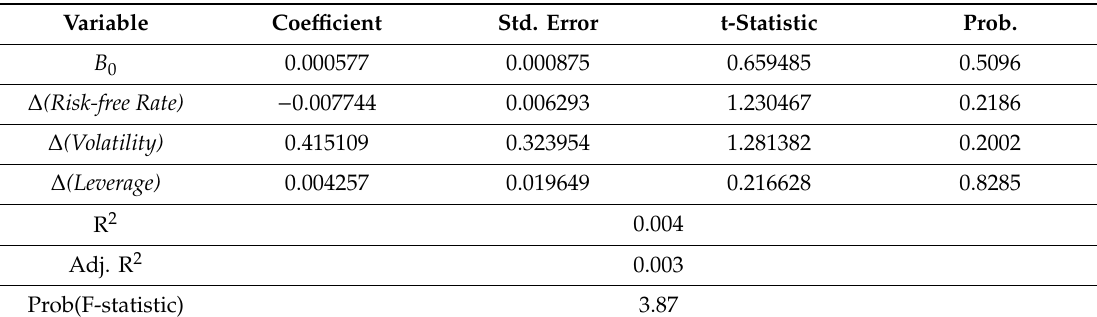
Table A8. Basic Model OLS estimates: period August 2007–September 2018 (2751 Obs. after adjustments).